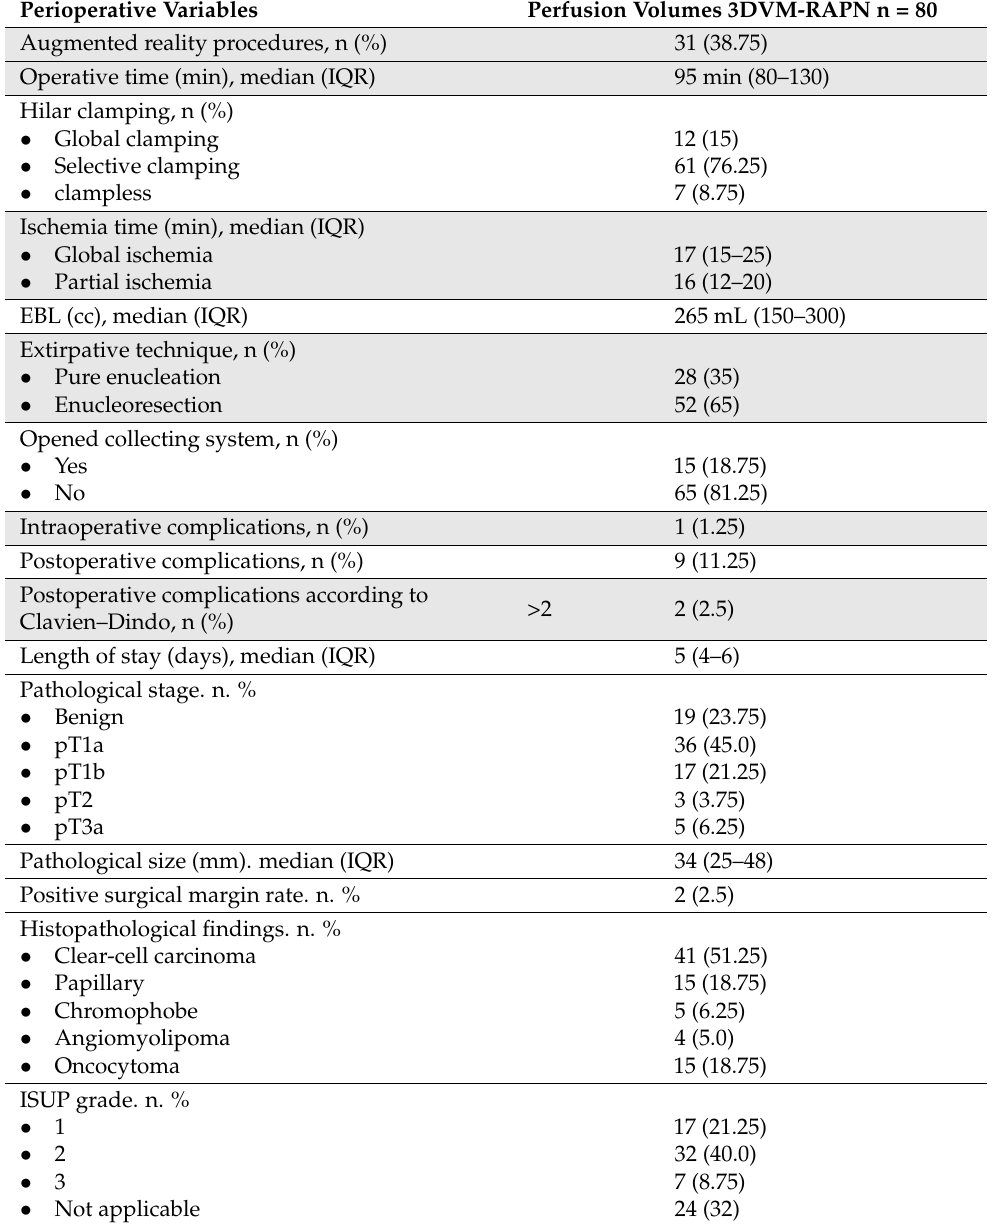
Table 2. Perioperative